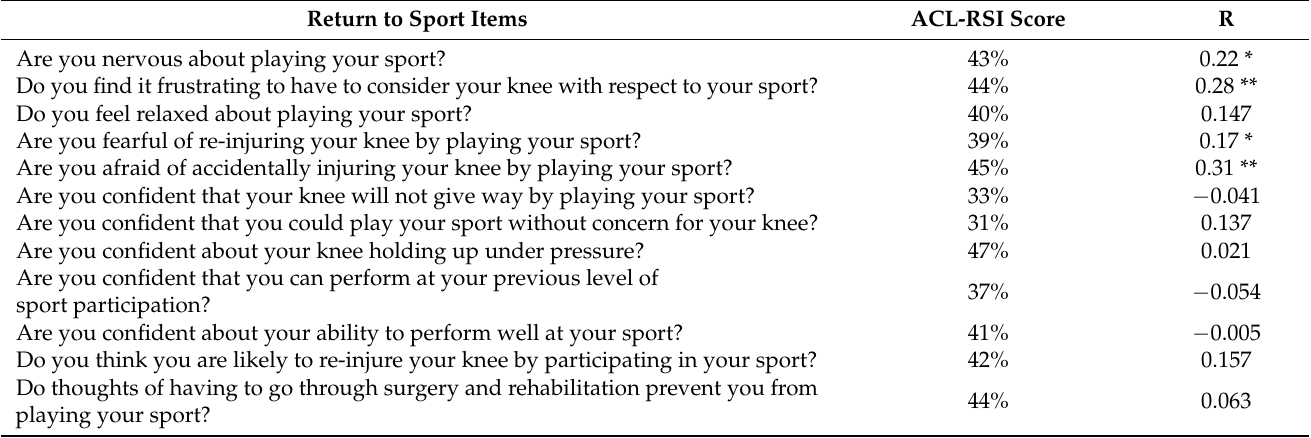
Table 5. Correlation between kinesiophobia and ACL-RSI scores among patients undergoing ACL reconstruction in Aseer Central Hospital, Saudi